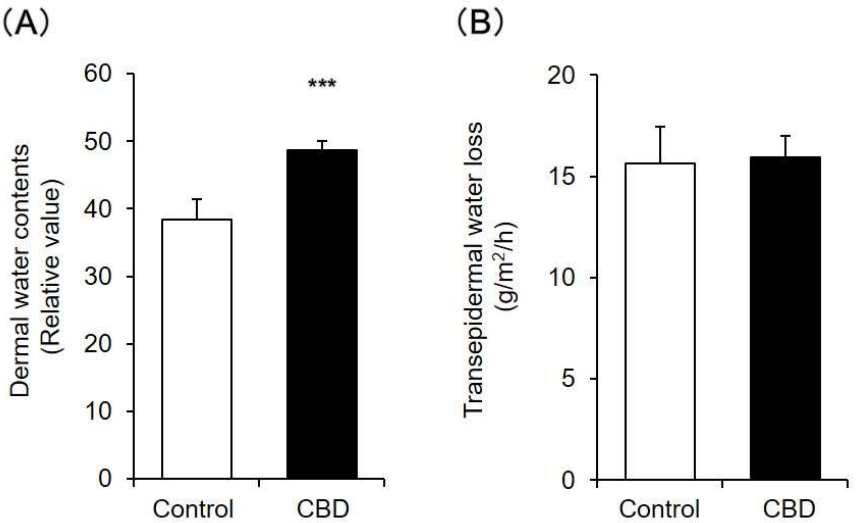
Figure 2. Dermal water content and TEWL. A 1% CBD solution was applied to the back skin of mice for 14 days. After the treatment, dermal water content ( A ) and TEWL ( B ) were measured ( n = 6, means ± SD, *** p < 0.001 vs. the control group).